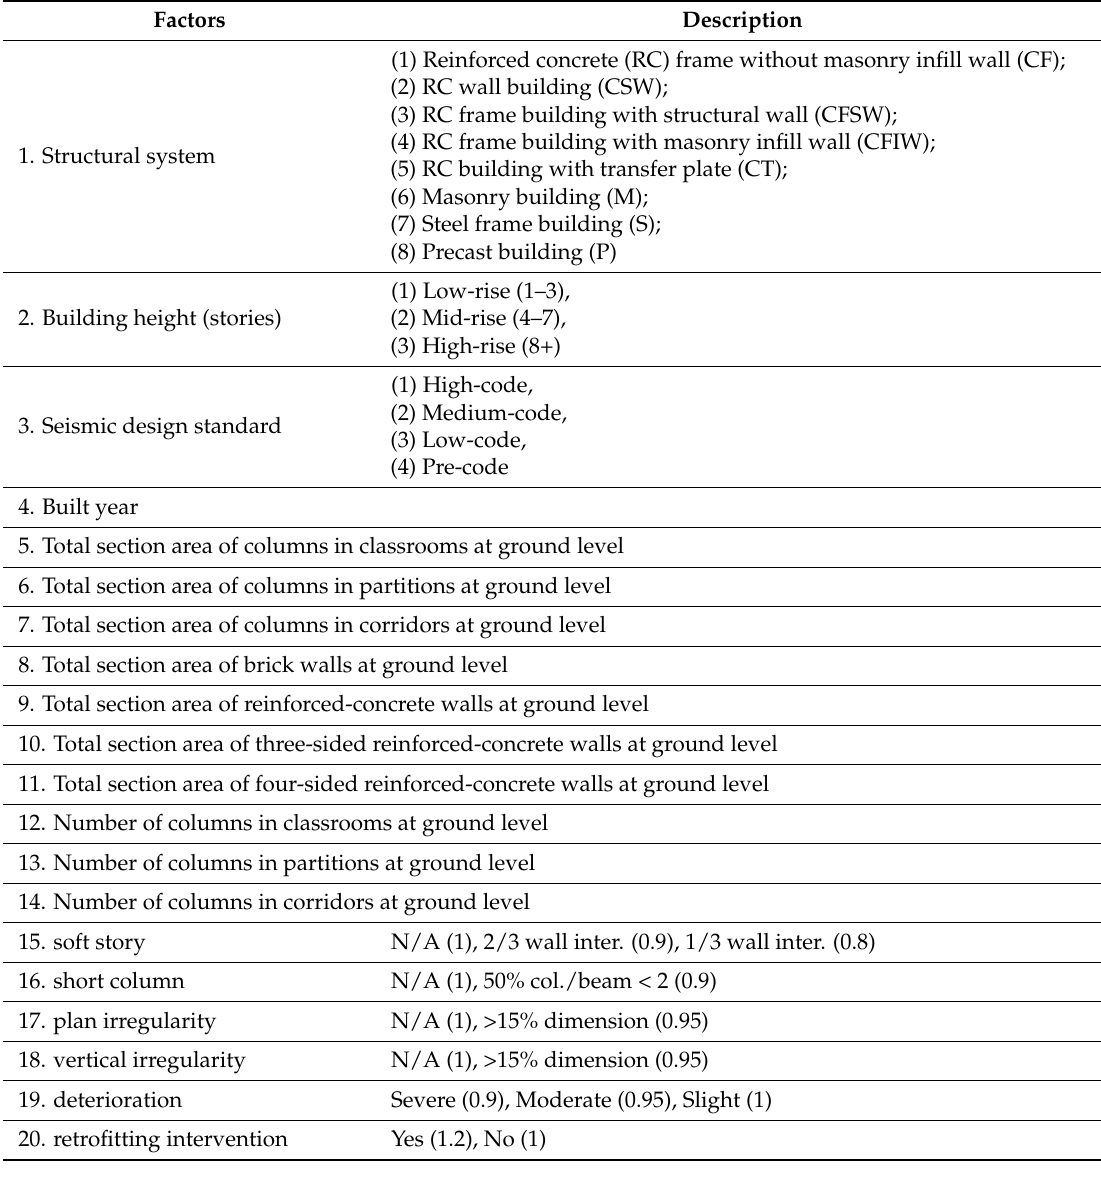
Table 2. Building